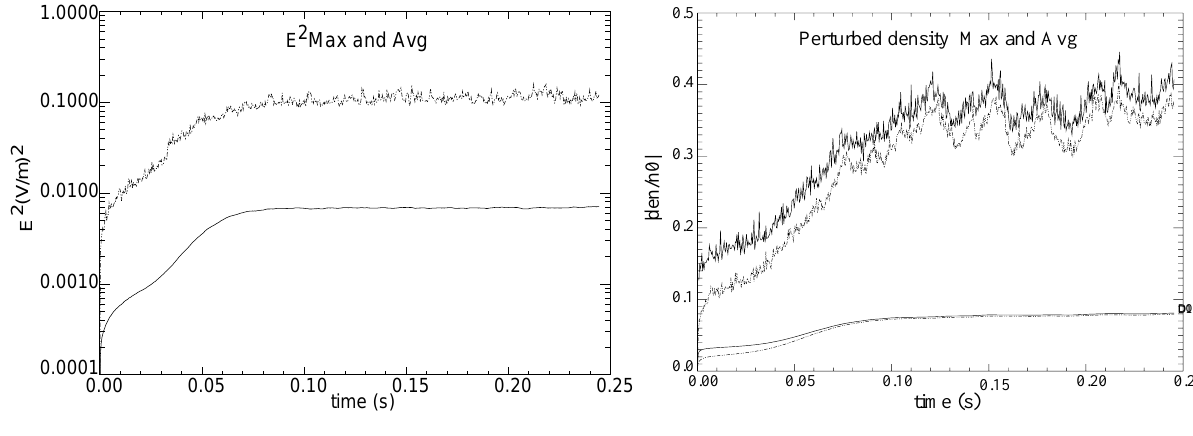
Fig. 2. Electric field energy and density perturbation maximum and average from baseline simulation. Left image shows the time evolution of the maximum (top) line and averaged electric field squared in (V/m) 2 . Right image shows the evolution of the maximum (top lines) and RMS of the perturbed density (bottom lines). The electron densities are shown with solid lines while ion densities with dashed lines. The base-line noise level of the simulation can be assessed from 10ms to